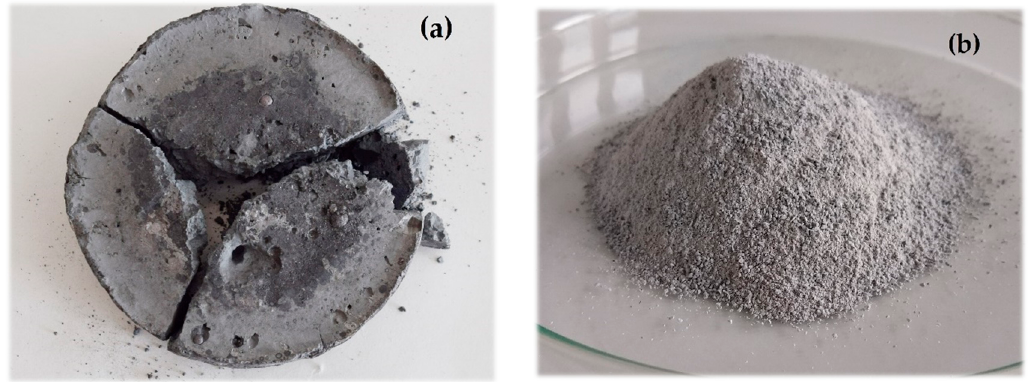
Figure 1. Li slag from EAF: ( a ) before mechanical pretreatment, ( b ) after mechanical pre-treatment consisting of crushing, grounding, magnetic separation, and sieving.